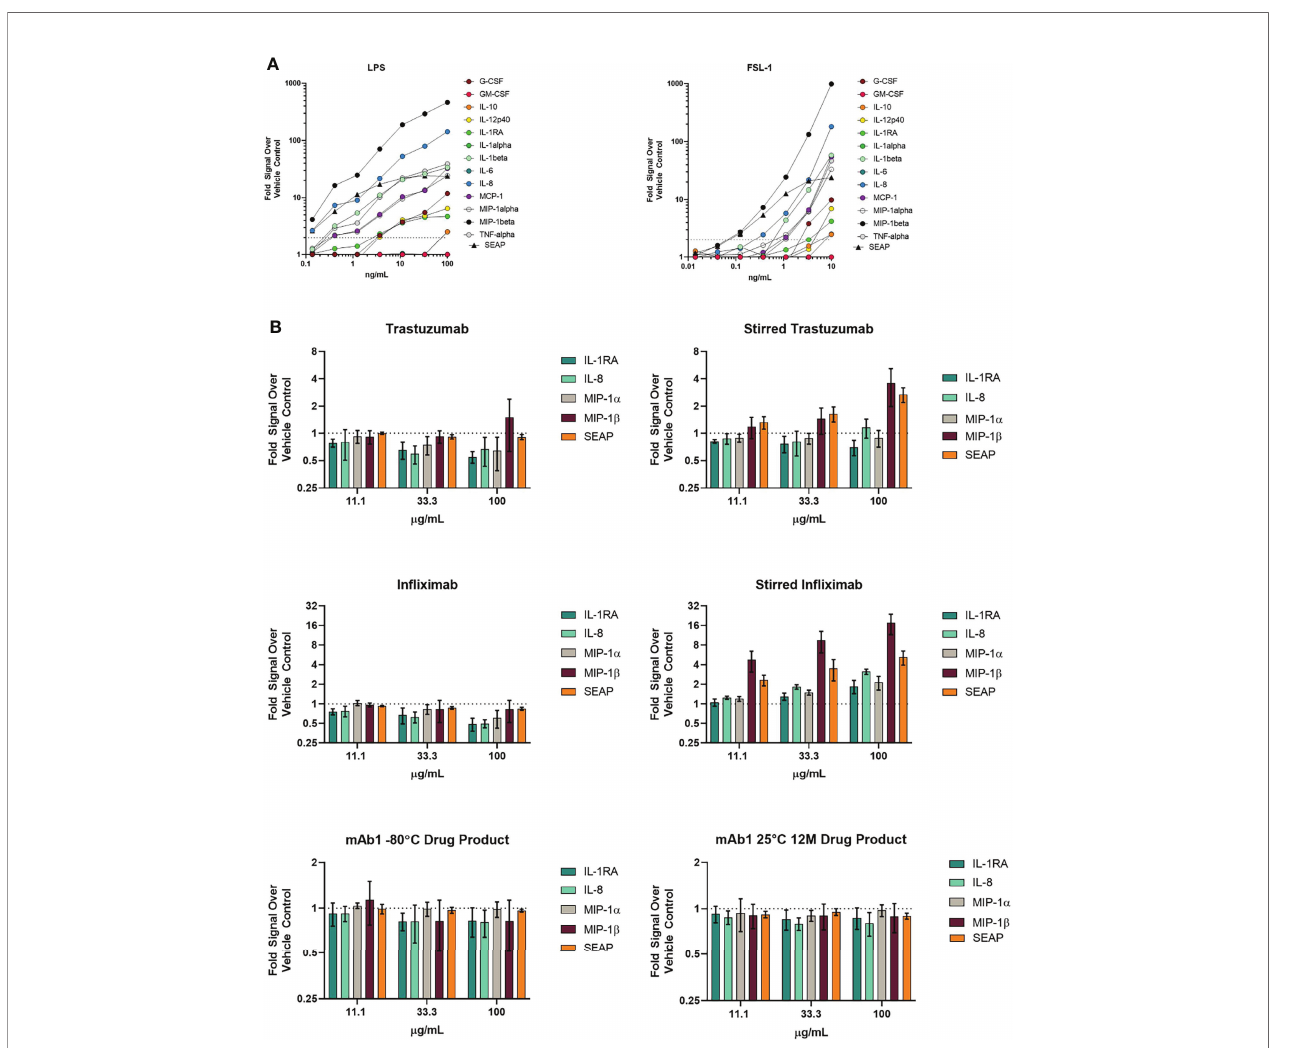
FIGURE 3 | THP-1 BLUE NF k B responses to TLR ligands and various antibodies with different amounts of aggregation. (A) SEAP reporter gene production in response to TLR ligands are similar with regards to cytokine/chemokine production responses. THP-1 BLUE NF k B cells were treated with varying concentrations of the TLR4 ligand LPS or the TLR2/TLR6 ligand FSL-1. 24 hrs later, supernatant was removed for quantitation of SEAP activity and cytokines/chemokines. The results are normalized to the signal from the vehicle control. Results are the average of 3 independent experiments. (B) THP-1 BLUE NF k B responses to stressed antibodies. THP-1 BLUE NF k B cells were treated with stir stressed and unstressed trastuzumab, in fl iximab, or mAb1 drug product that had been stored at -80°C or at 25°C for 12 months. The cells were treated with three different concentrations. Results are the average of 3 independent experiments. Error bars represent